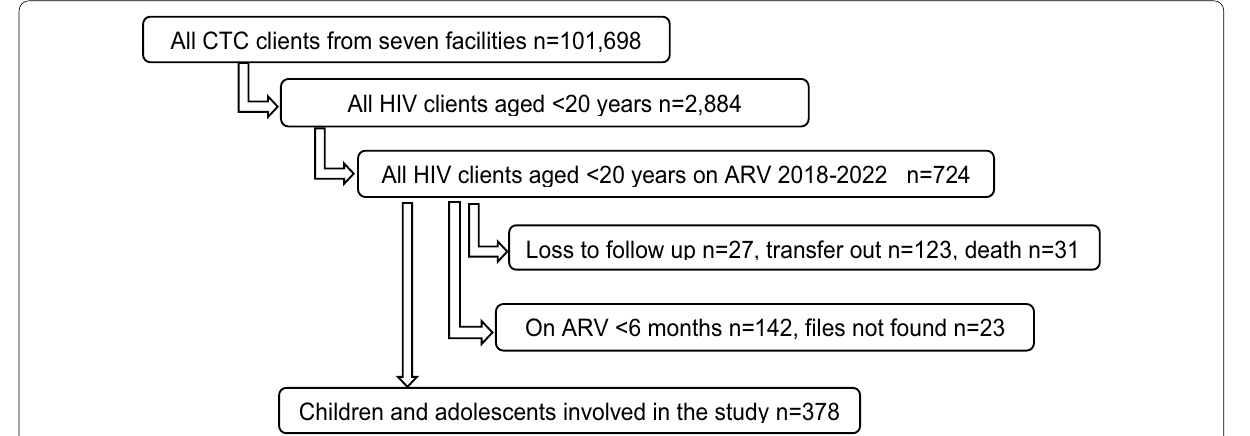
Fig. 1 A scheme showing the data of children and adolescents on